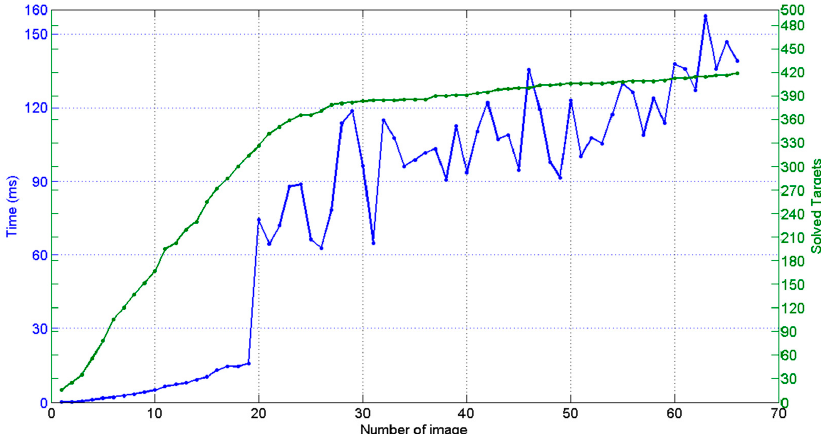
Figure 11. In-process intermediate bundle (step 6) computing time (ms) and number of solved targets